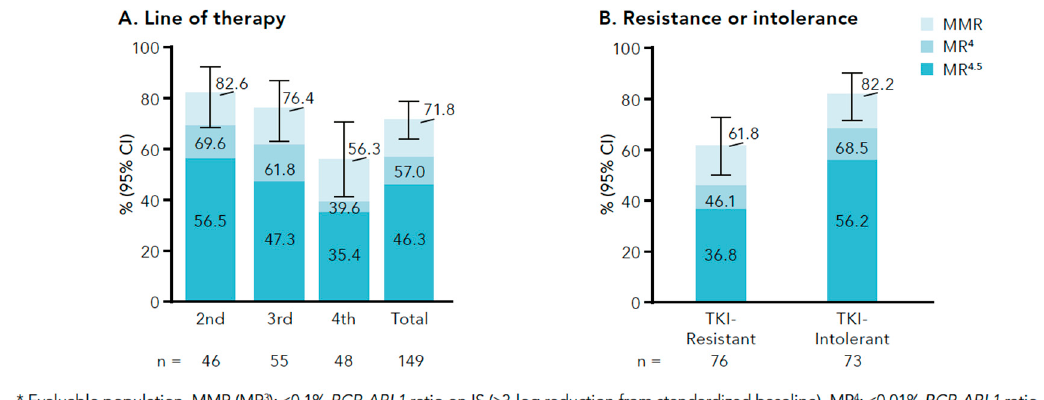
Figure 2. Summary of cumulative incidence of molecular response in CP CML patients enrolled in